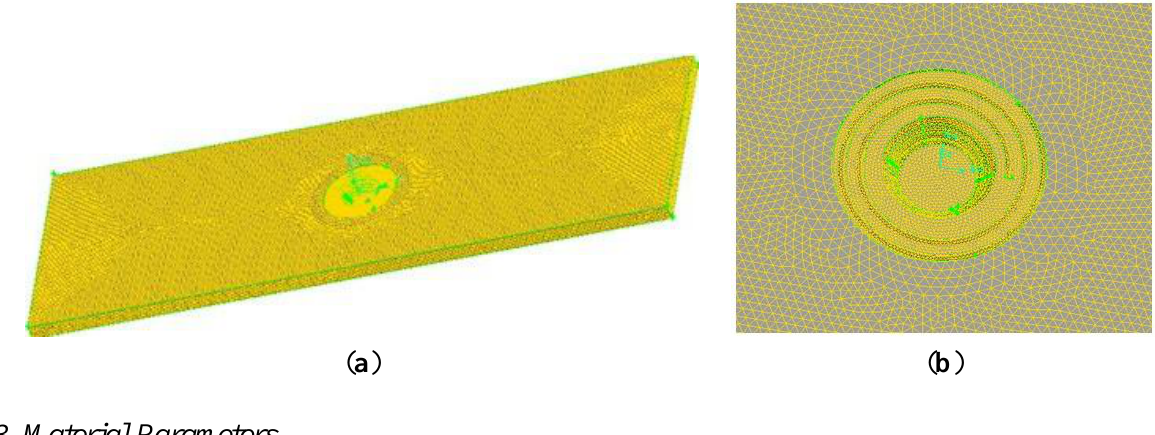
Figure 2. ( a ) Mesh generation of model used in simulation; ( b ) Partial enlarged figure of